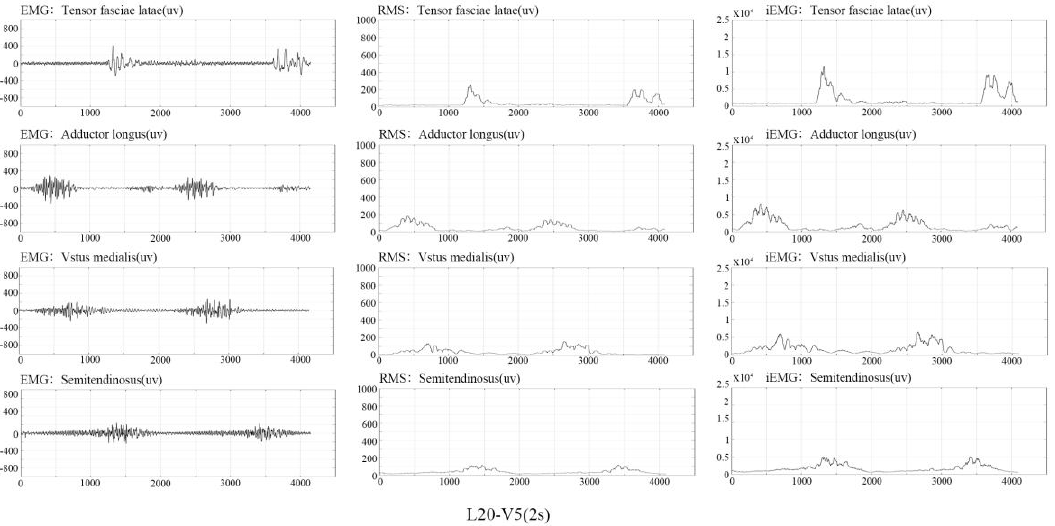
Figure 3. Raw sEMG, RMS , and iEMG for the four muscles from one subject, with L20 at V5. Table 1. Accuracy of recognition of the five gait phases (%), the accuracy of the gait recognition (%) under each load and speed, and the total average accuracy of the gait recognition (Total Avg) (%) among the four loads under each speed.